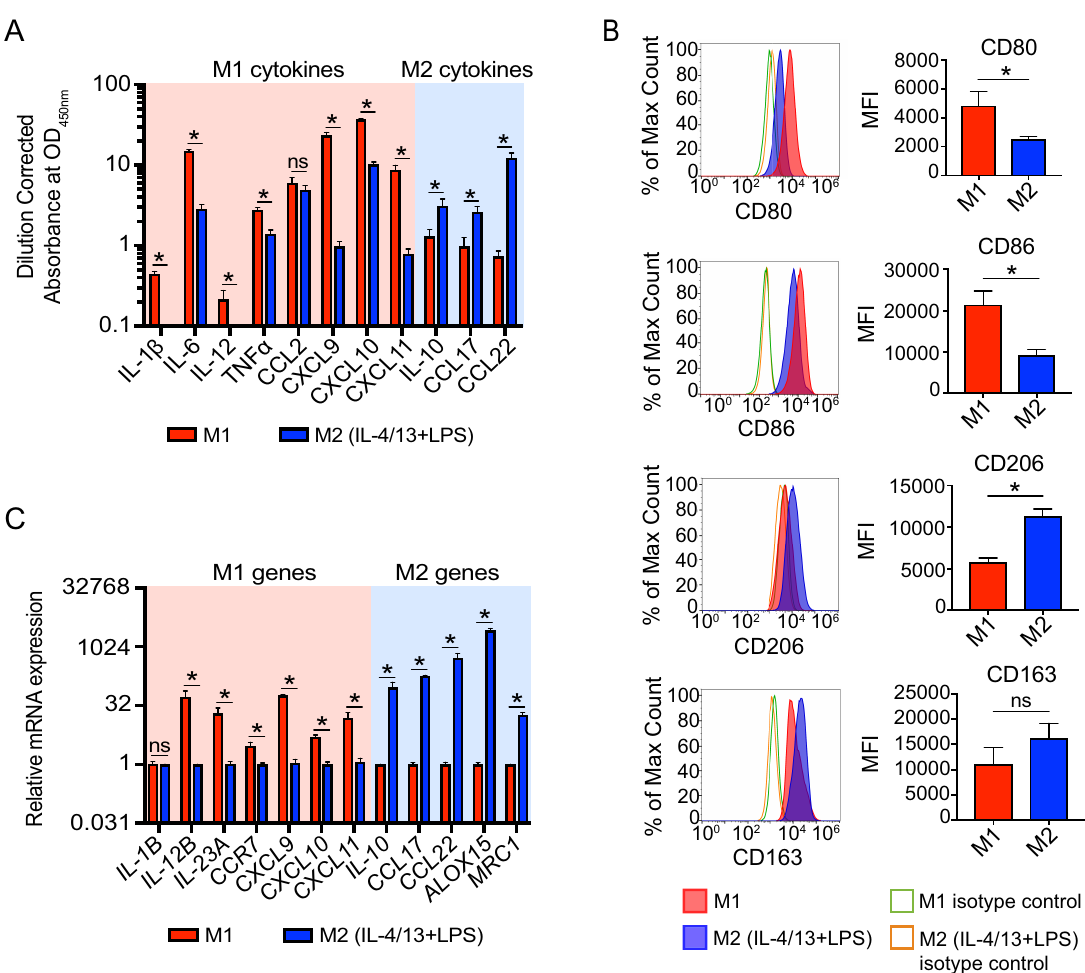
Fig 2. Delayed addition of LPS to conventional M2 polarization conditions phenotypically and functionally polarizes M2 macrophages. (A) Differential cytokine secretion profiles of M1 macrophages and M2 macrophages exposed to IL-4, IL-13, and LPS. (B) Differential cell surface marker expression. MFI indicates mean fluorescence intensity. (C) Differential gene expression. For panels A and C, canonical M1 and M2 cytokines and genes are highlighted in the pink and blue background, respectively. � p < 0.05 and error bars represent SEM of 4 biological replicates. ns = not